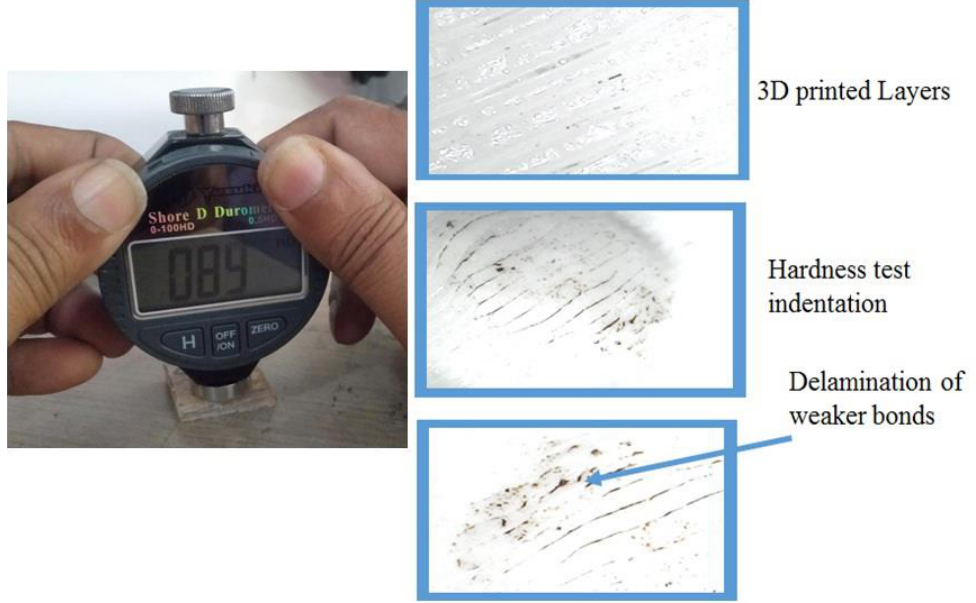
Figure 10. Hardness test setup and delamination of weaker bonds of 3D-printed test specimen.